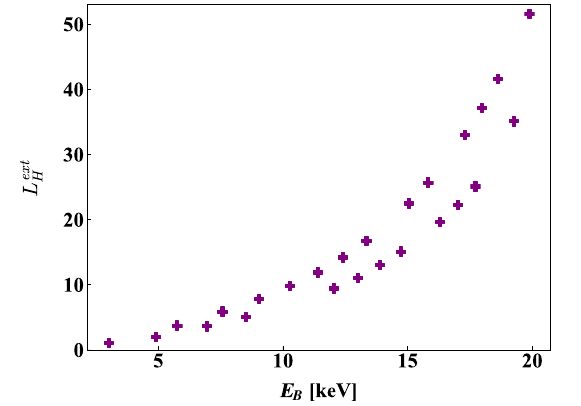
FIG. 11. Calculated extinction length for x-rays in Bragg backscattering from different